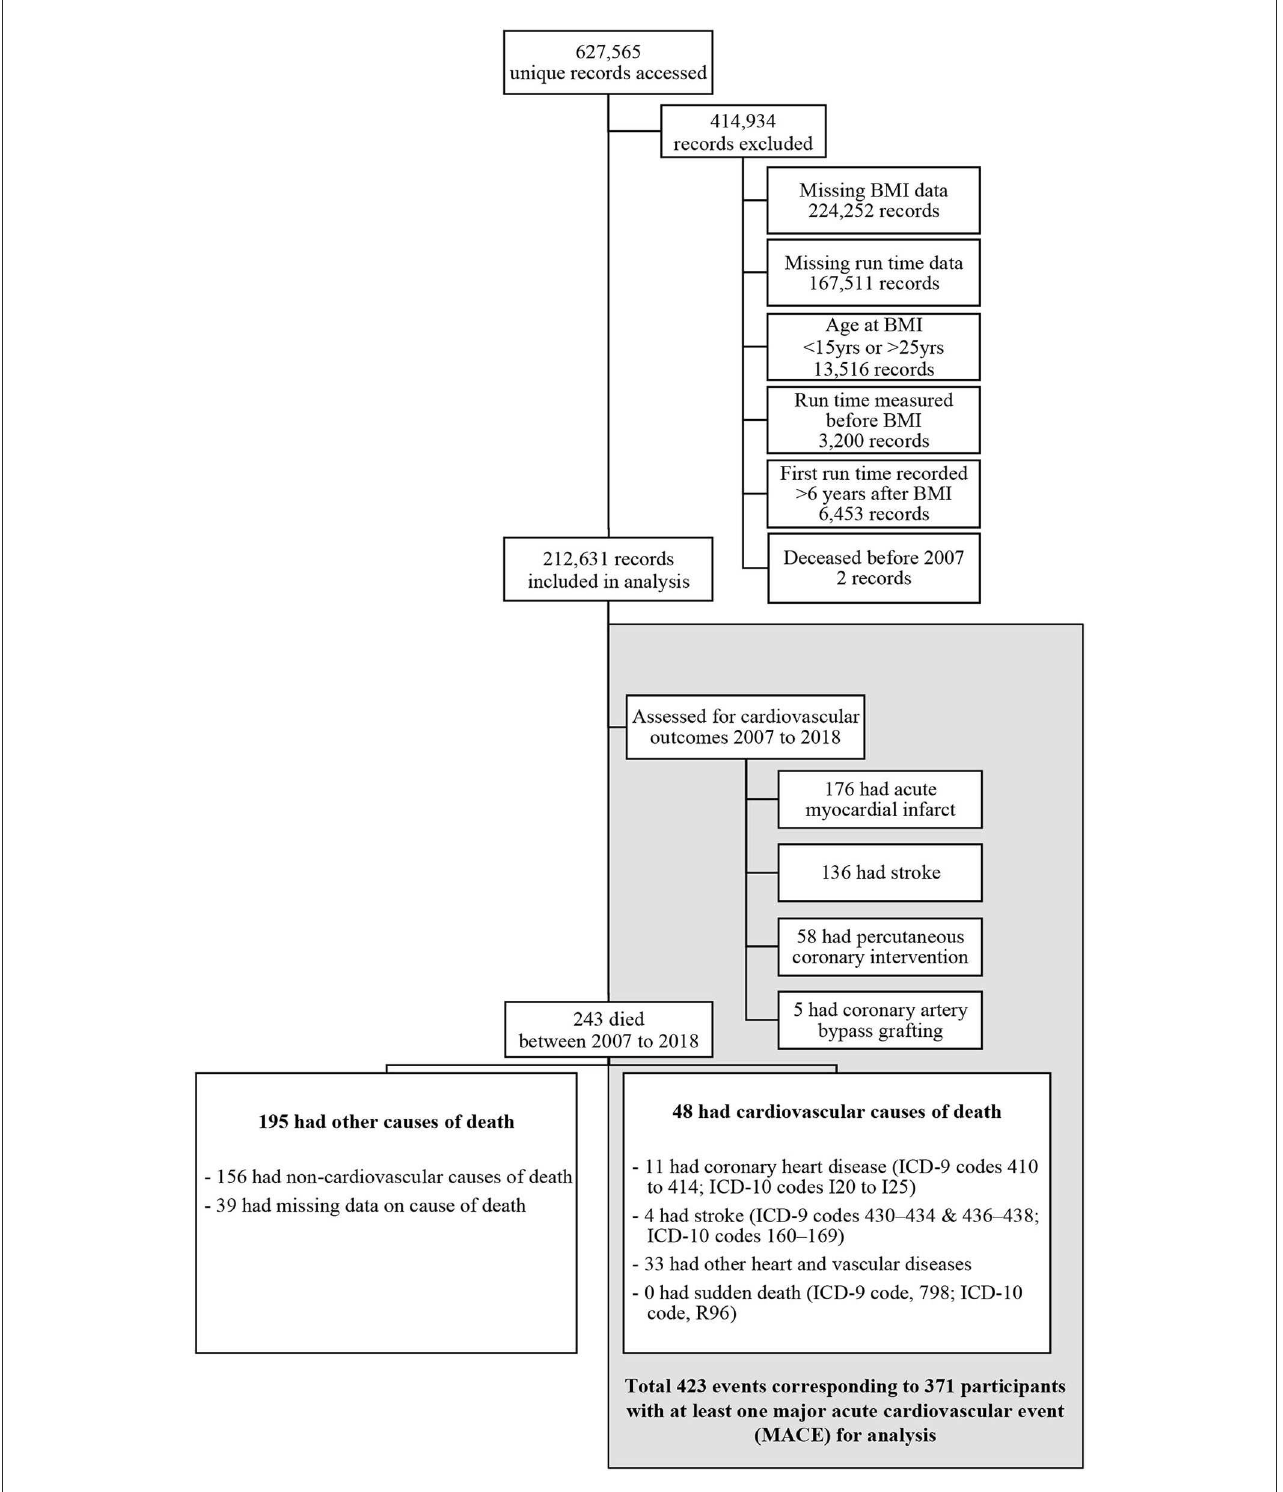
FIGURE1 Study sample and outcome events.